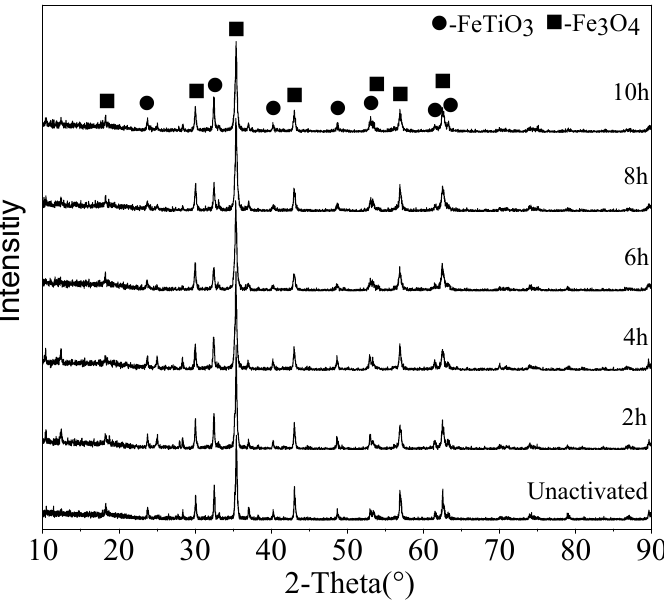
Figure 5. XRD patterns of the VTMCs mechanically activated at different times.